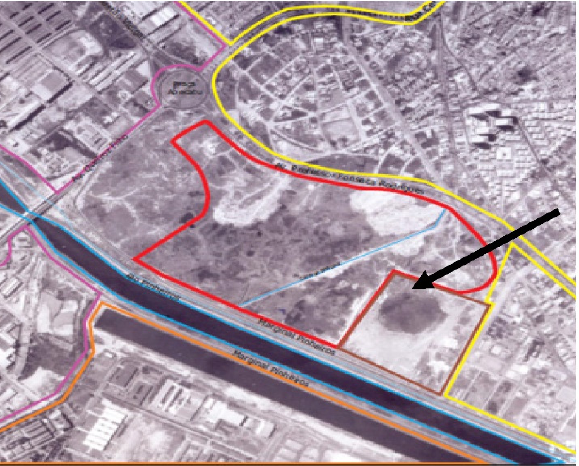
Figure 6. Villa-Lobos. Disposal of dredged material next to the old sand mine in 1977 [19].